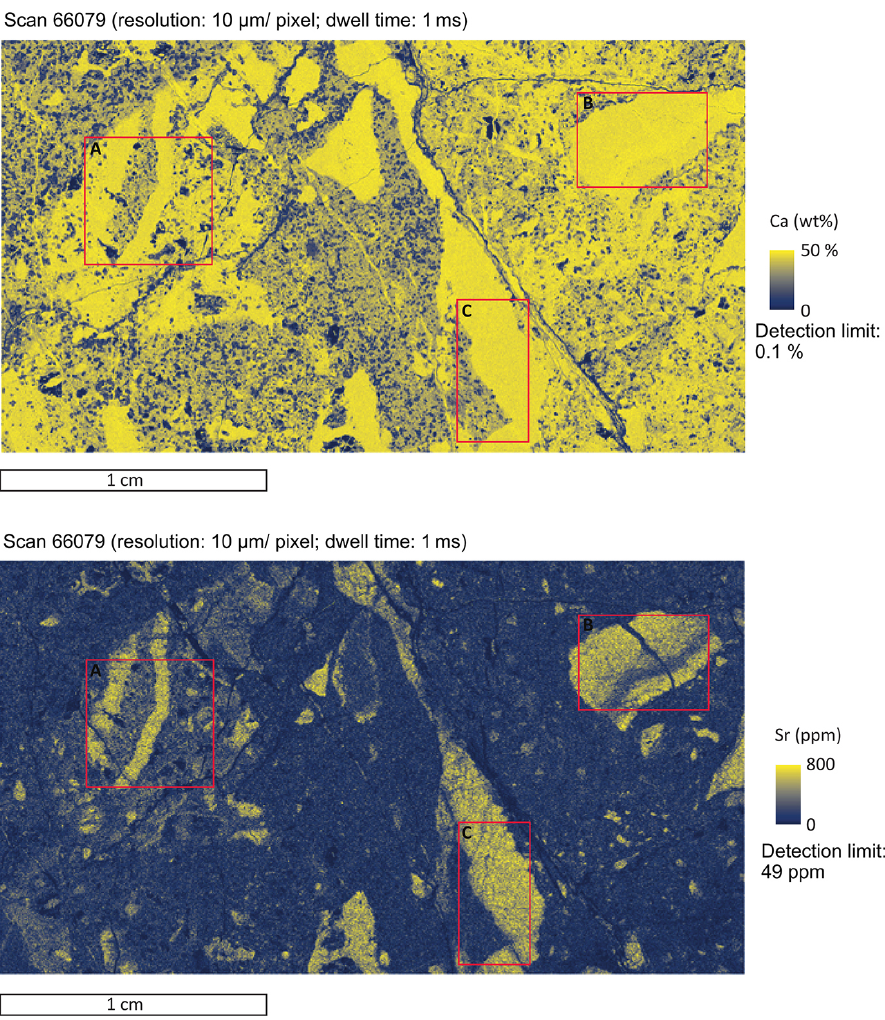
Figure B2. Coarse scan of the investigation areas on sample 17NP436a for Ca and Sr. Area A shows a rock fragment fringed by radial- fibrous calcite cement. The right fissure shows calcite growing from both walls toward the center, showing lower Sr values in the center of the vein. Area B shows an isolated fragment of radial fibrous to equant cement with Sr and Ca zoning. High Sr/low Ca values occur in the radial-fibrous calcite along the lower-right boundary with an abrupt change to low Sr/high Ca values in the center that grade into high Sr/low Ca values in a broad zone along the upper-left boundary. The low Sr/high Ca values occur at the transition from radial fibrous to equant calcite crystals. A younger calcite-filled fissure crosscuts the calcite cement fragment. Crucial are the much lower Sr values. This fissure formed during tectonic straining of the rock, pressure solution, and reprecipitation of calcite. Area C shows calcite crystals with highest Sr/lowest Ca values in the center of the single